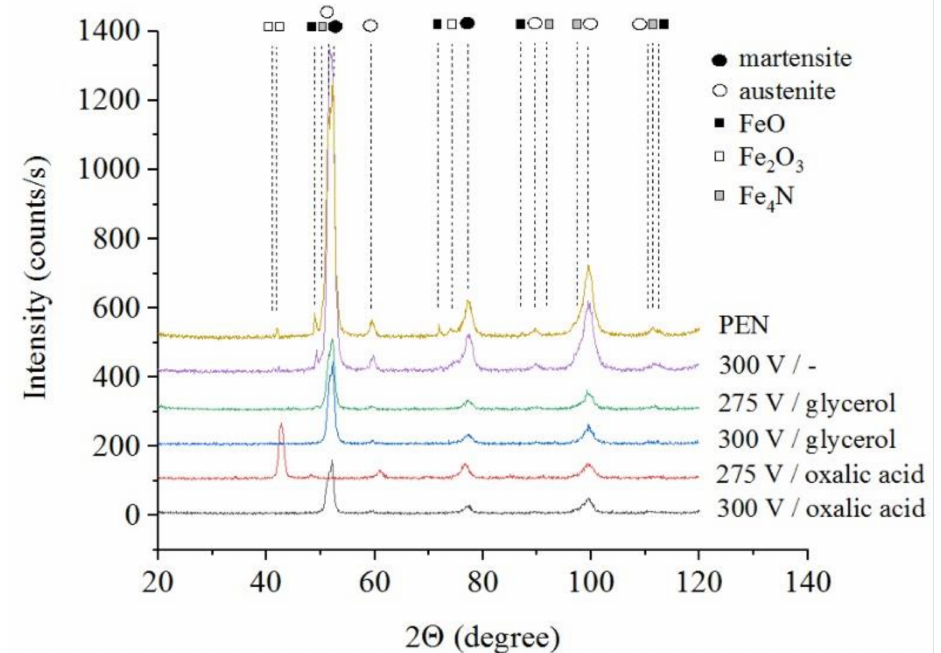
Figure 2. X-ray diffraction patterns of the steel surface layer after PEN and subsequent PEP in ammonium chloride (3%) solution with temperature of 80 ◦ C without or with glycerol or oxalic acid additions (5% each) at different voltages under forced circulation of